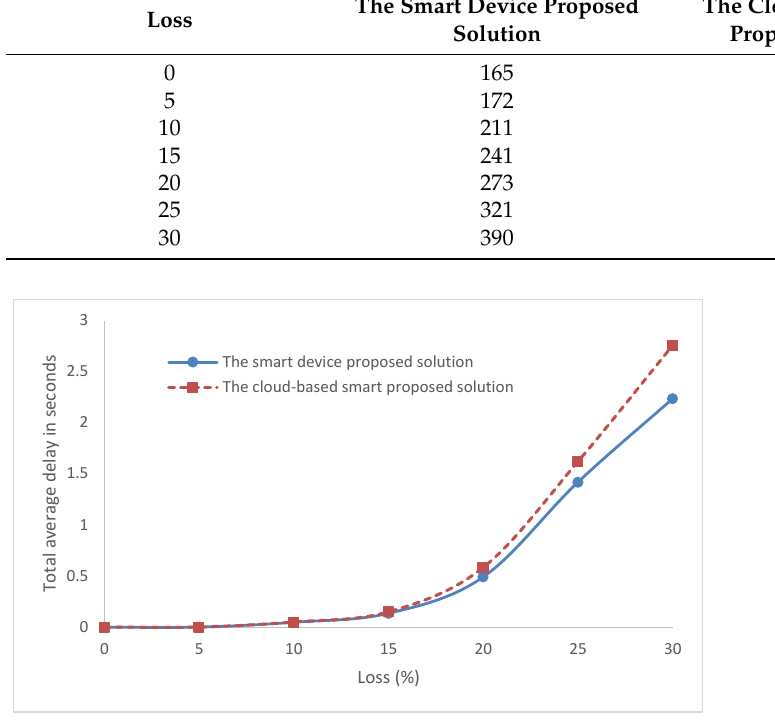
Figure 11. The total average delay for message. Table 3. The total average delay (seconds) for message for the two solutions with network